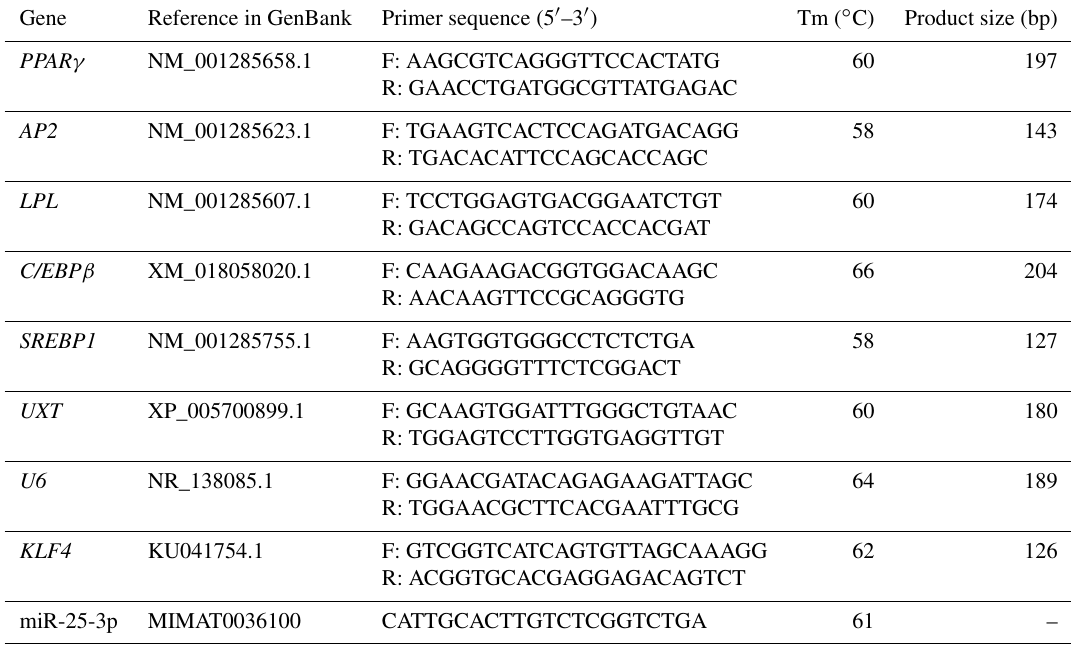
Table 2. Primers utilized in this study. Gene Reference in GenBank Primer sequence (5 (cid:48) –3 (cid:48) ) Tm ( ◦ C) Product size